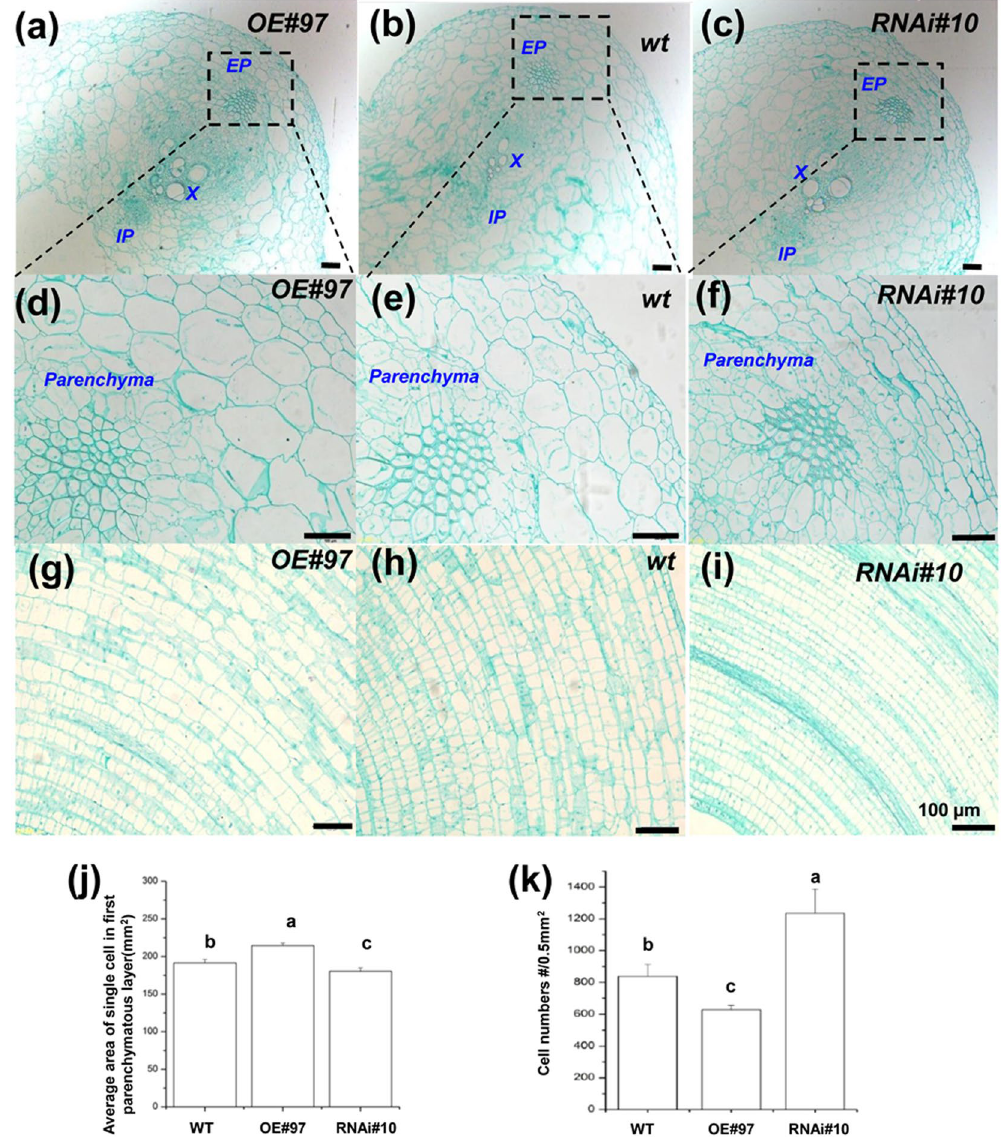
Figure 7. Cross and longitudinal sections of 6-d-old WT and transgenic cucumber seedlings grown in darkness. Hypocotyl cross sections of ( a ) OE line 97, ( b ) WT, and ( c ) RNA line 10. Magnified images of the hypocotyl cross sections of ( d ) OE line 97, ( e ) WT, and ( f ) RNAi line 10 were analyzed. Scale = 100 µ m. EP, external phloem; IP, internal phloem; X, xylem; PP, parenchymal cell; BS, vascular bundle sheath; CC, companion cell; SE, sieve element. Longitudinal sections of the hypocotyls in ( g ) OE line 97, ( h ) WT, and ( i ) RNAi line 10. The dotted lines indicate the direction of the bending and the arrows indicate sieve element cells. ( j ) Average single cell area in the first layer of parenchymal cells in hypocotyl. ( k ) Average number of cells per 0.5 mm 2 in hypocotyl. (n = three visual fields). Values that differed significantly from the WT values are indicated. * p < 0.05 and according to a Bonferroni post-hoc